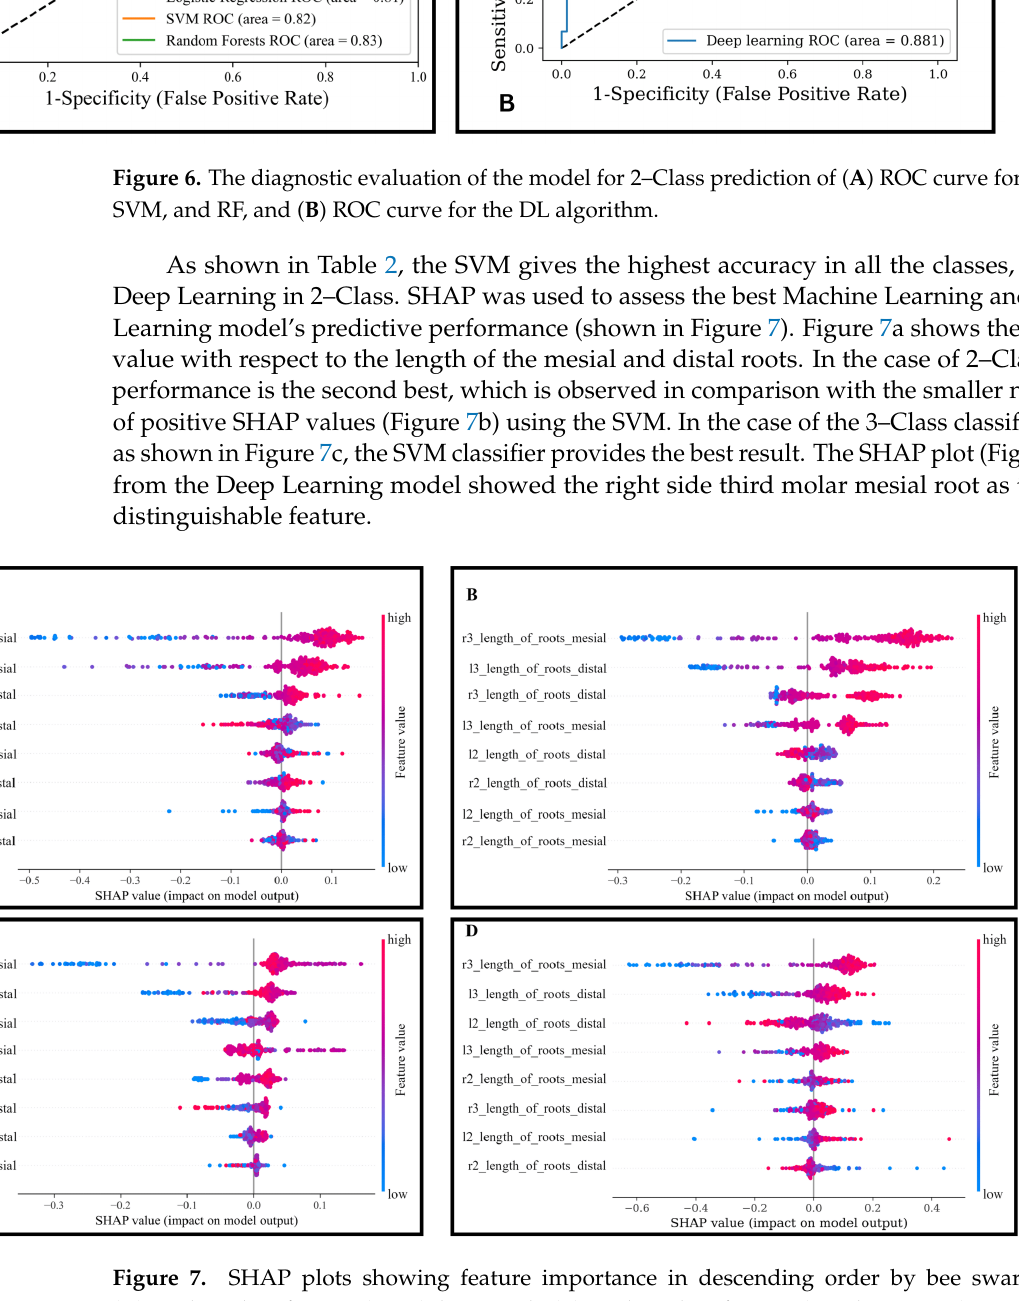
Figure 6. The diagnostic evaluation of the model for 2–Class prediction of ( A ) ROC curve for the LR, SVM, and RF, and ( B ) ROC curve for the DL algorithm.